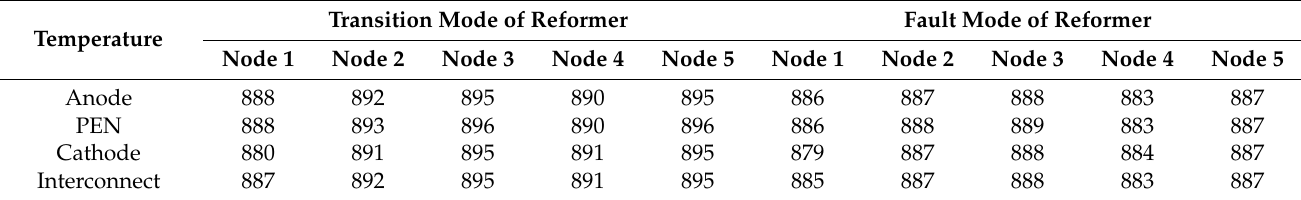
Table 8. Temperature distribution of SOFC stack nodes due to the reformer fault.